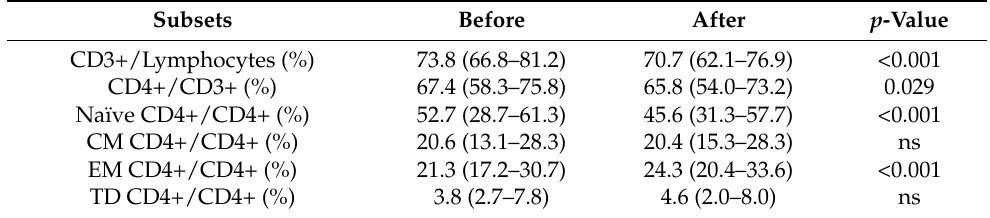
Table A1. Frequency of T and B cell subsets in the lung transplant candidates before and after